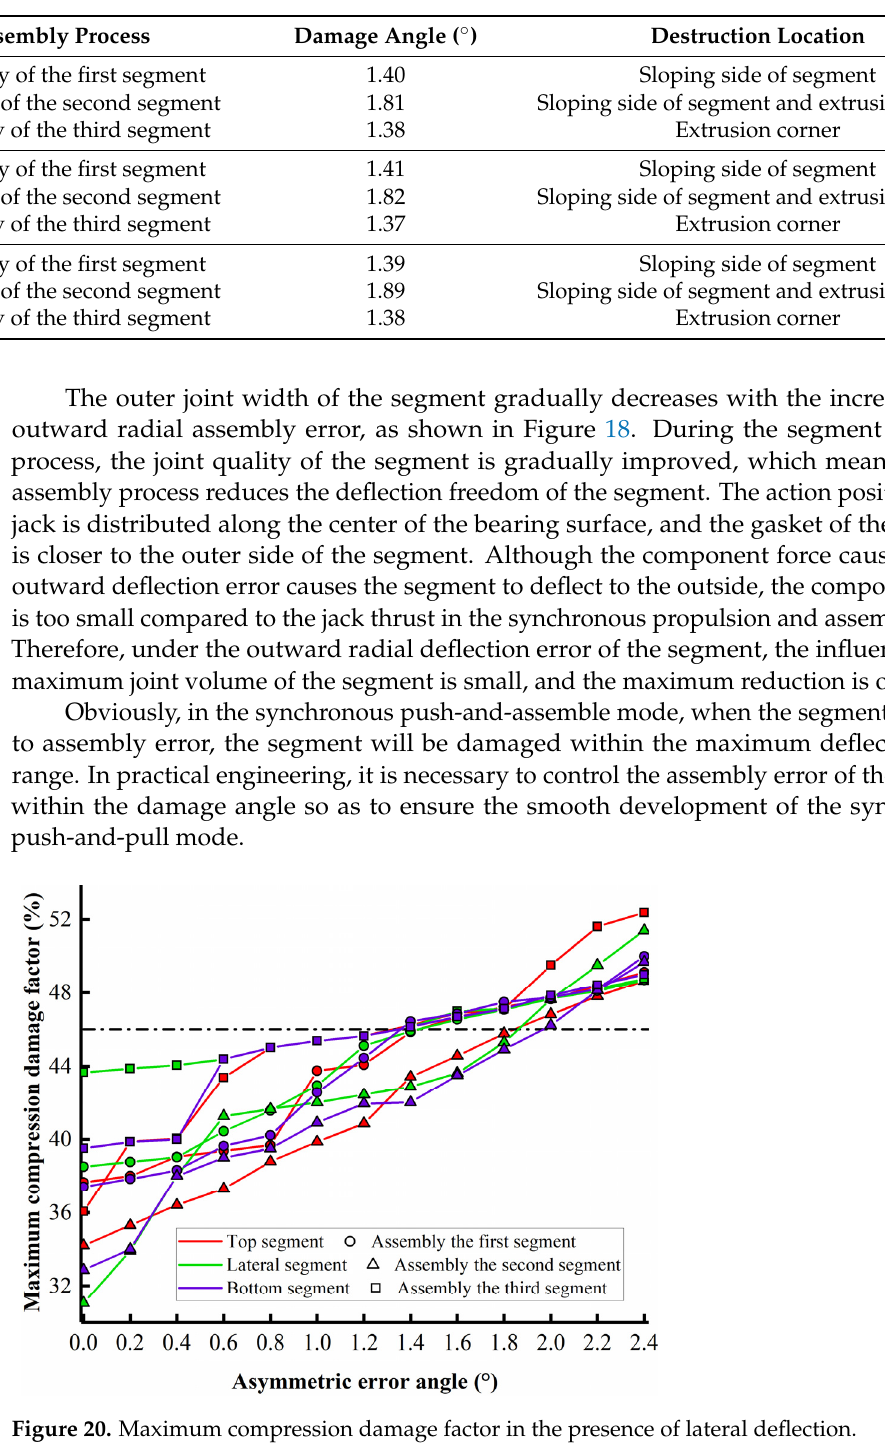
Table 6. Damage to the segments.